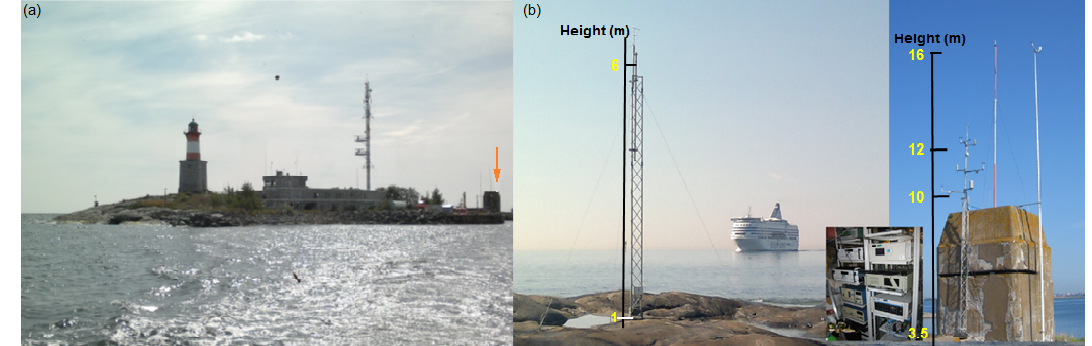
Figure 2. (a) A photograph of Harmaja Island; the orange arrow points to the measurement tower. (b) Measurement instrumentation was installed in racks inside the fire control tower. The mast on the right includes all of the measurement probes (wind and temperature probes and sample intakes) for the gradient and eddy-covariance methods during the 2011 campaign, whereas the mast on the left includes the probes and sample inputs for the eddy-covariance method and for measuring gas and particle concentration during the 2012 campaign. Both masts faced the open sea. The masts stood approximately 20m from the shoreline and 3.5ma.m.s.l. in 2011, and 3m from the shoreline